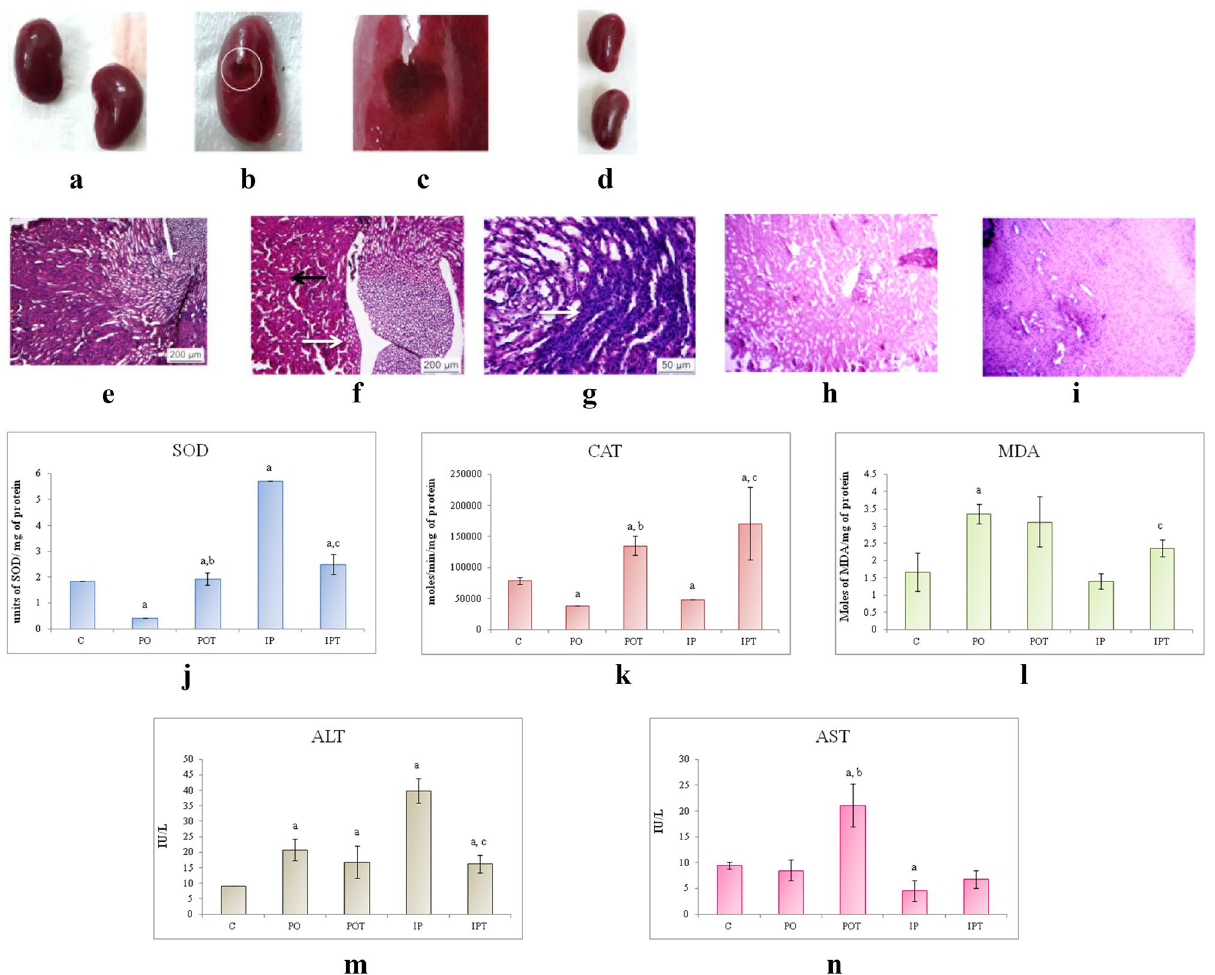
Figure 5. Photographs of kidney of ( a ) control, ( b ) IP group showing gross lesions as indicated by a circle, ( c ) enlarged view of the lesion, ( d ) treatment group with no pathological changes. Photomicrographs of TS of kidney, ( e ) control (HE, ×100), ( f ) PO-showing vacuolization (white arrow) and haemorrhage (black arrow) in the medulla region (HE, ×100), ( g ) IP-showing infiltration in cortical region (HE, ×400), ( h ) POT-treated mouse showing no pathology (HE, ×100), ( i ) IPT-treated mouse showing no pathology (HE, ×100). ( j ) Comparison of SOD activity in the kidney of control, experimental and treated animals. ( k ) Comparison of CAT activity in the kidney of control, experimental and treated animals. ( l ) Comparison of MDA activity in the kidney of control, experimental and treated animals. ( m ) Comparison of ALT activity in the kidney of control, experimental and treated animals. ( n ) Comparison of AST activity in the kidney of control, experimental and treated animals. The results of biochemical assays are shown in mean ± SE (‘a’ symbolizes p < 0.005 control vs experimental groups,